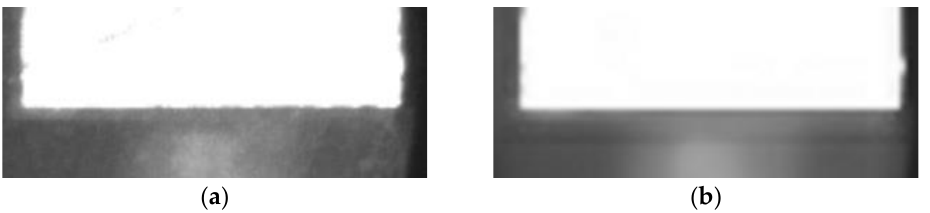
Figure 9. Bilateral filtering diagram.